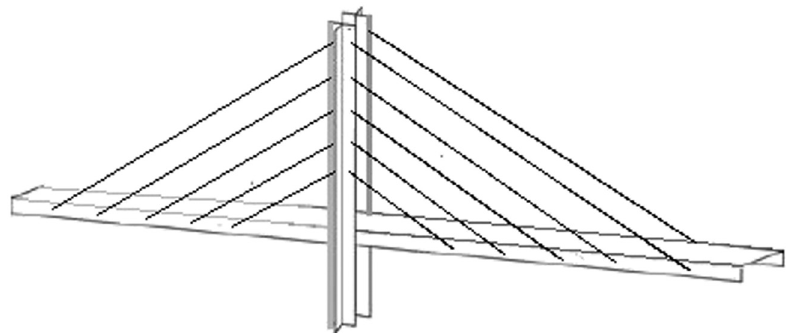
Figure 1: The concept of the